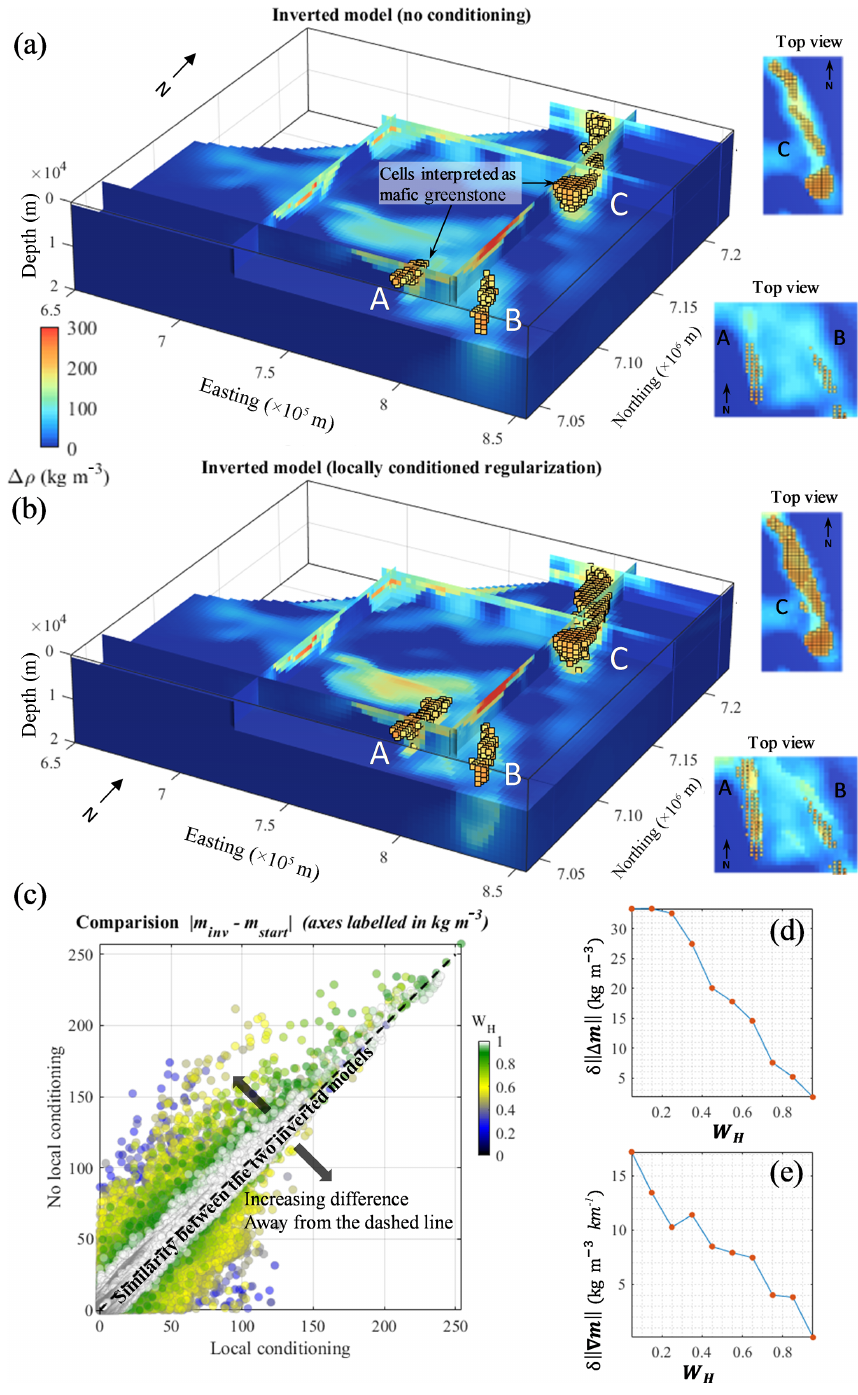
Figure 8. Comparison of inversion results. (a) Inverted models with non-conditioned regularization weights, and (b) using local conditioning, (c) cross-plot between the corresponding absolute value of the update of the prior model, (d) difference in model updates δ | (cid:49)m | = | m cond − m nocond | 2 as a function of values of W H and (e) difference in model roughness δ |∇ m | = |∇ m cond | 2 −|∇ m nocond | 2 as a function of values of W H . The model cells labelled A–C are interpreted as mafic greenstone belts. All voxels are coloured as a function of density contrast.